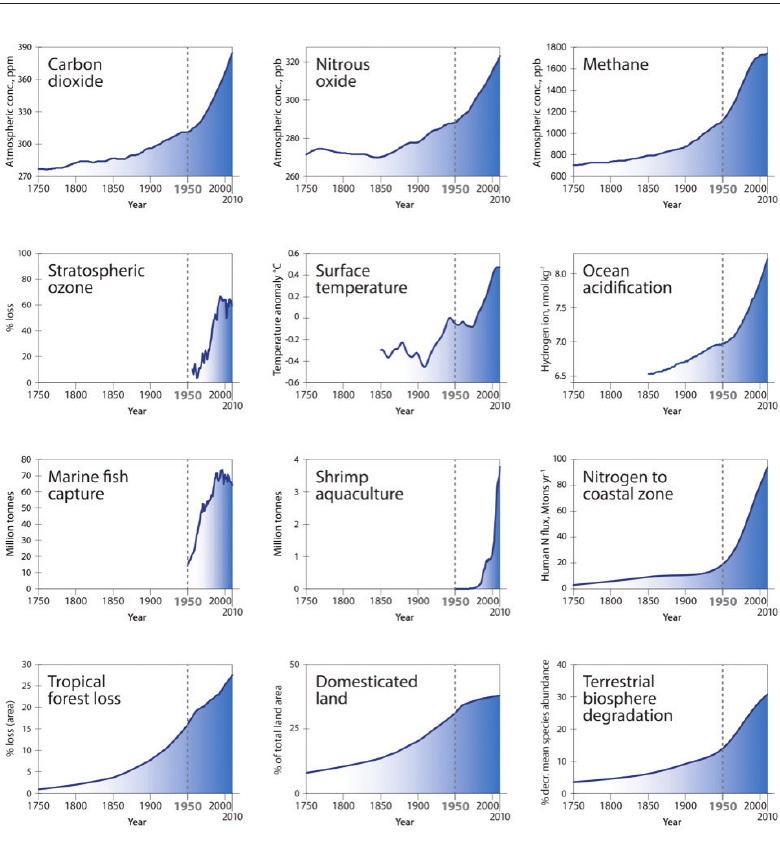
Figure 5: Earth system trends. Reproduced by kind permission of Will